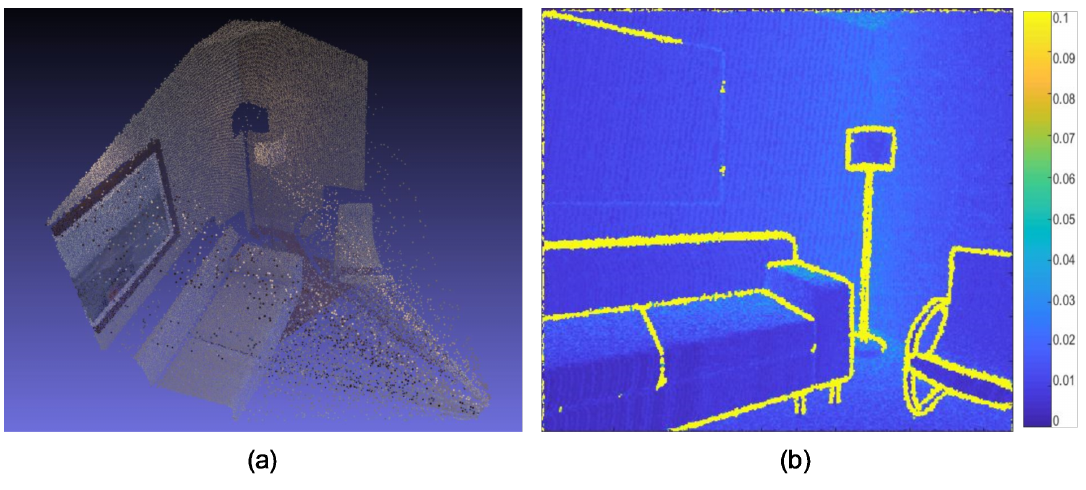
Figure 6. Uncertainty model applied to the depth image. ( a ) Point cloud from the original depth image and ( b ) the uncertainty map.